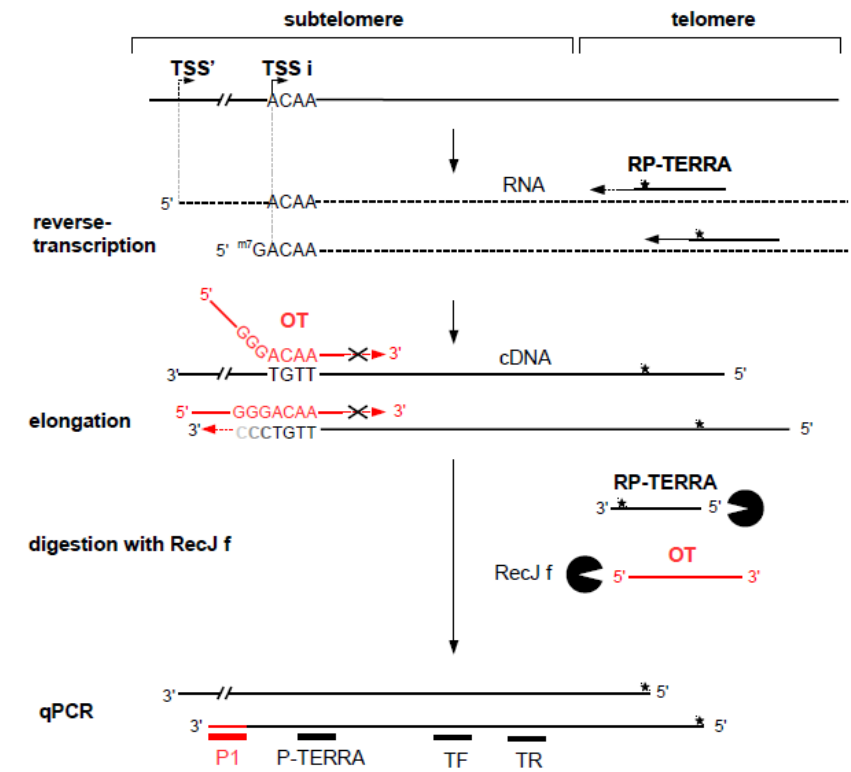
Figure 2. Schematic representation of the method for TERRA quantification from a single transcription start site (TSS) by analysis of particular TSS (AP-TSS). TERRA transcripts are produced from multiple TSSs located on subtelomeres. Two TSSs are illustrated here: the TSS of interest (TSSi) and a putative TSS located upstream (TSS’). TERRA (dashed line) is reverse transcribed using primer RP-TERRA complementary to the telomeric G-rich strand. As this primer can bind to sites throughout the telomeric repeat sequence, the 5′ ends of the cDNAs produced are of various lengths. Phosphorothioate bonds in the 3′-terminal part of RP-TERRA are represented with a black star. The produced cDNAs have subtelomeric sequences of variable length, depending on the TSS of origin. Template oligonucleotide (OT) (red) hybridizes with the 3′ end of the cDNA from the TSSi and serves as template for specific elongation of the cDNA. OT is blocked at its 3′ end by dideoxycytidines to prevent elongation. Oligonucleotides RP-TERRA and OT are digested by the 5′ exonuclease RecJf; the phosphorothioate bonds in the 3′-terminal part of RP-TERRA protect the cDNAs from digestion. Elongated cDNAs are quantified by qPCR using P1 and P-TERRA primers. TR and TF primers allow quantification of total TERRA from subtelomeres Xq, Yq, 15q, and 9p.